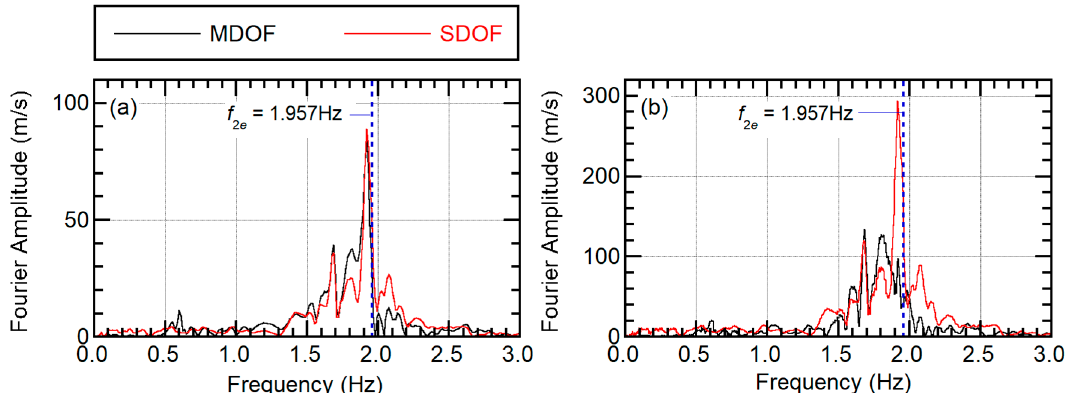
Figure 21. Comparisons of Fourier amplitudes of second modal acceleration: ( a ) Art-S06, 50%; ( b ) Art-S06, 100%.